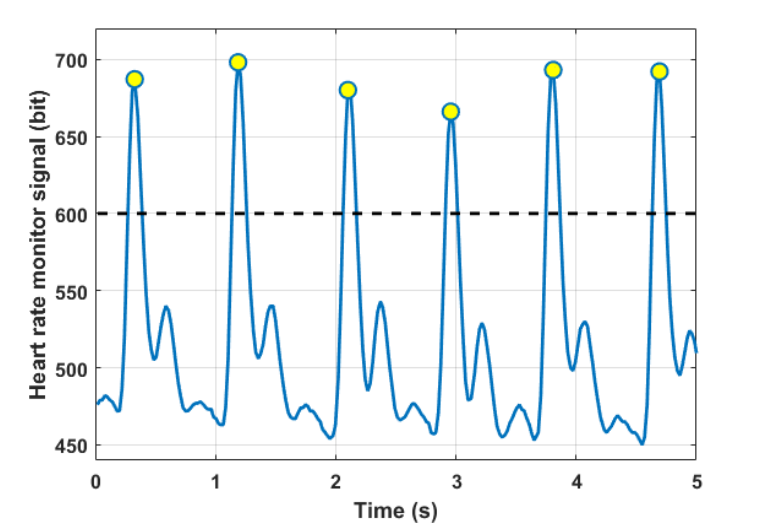
Figure 10. Heart rate sensor signal for BPM